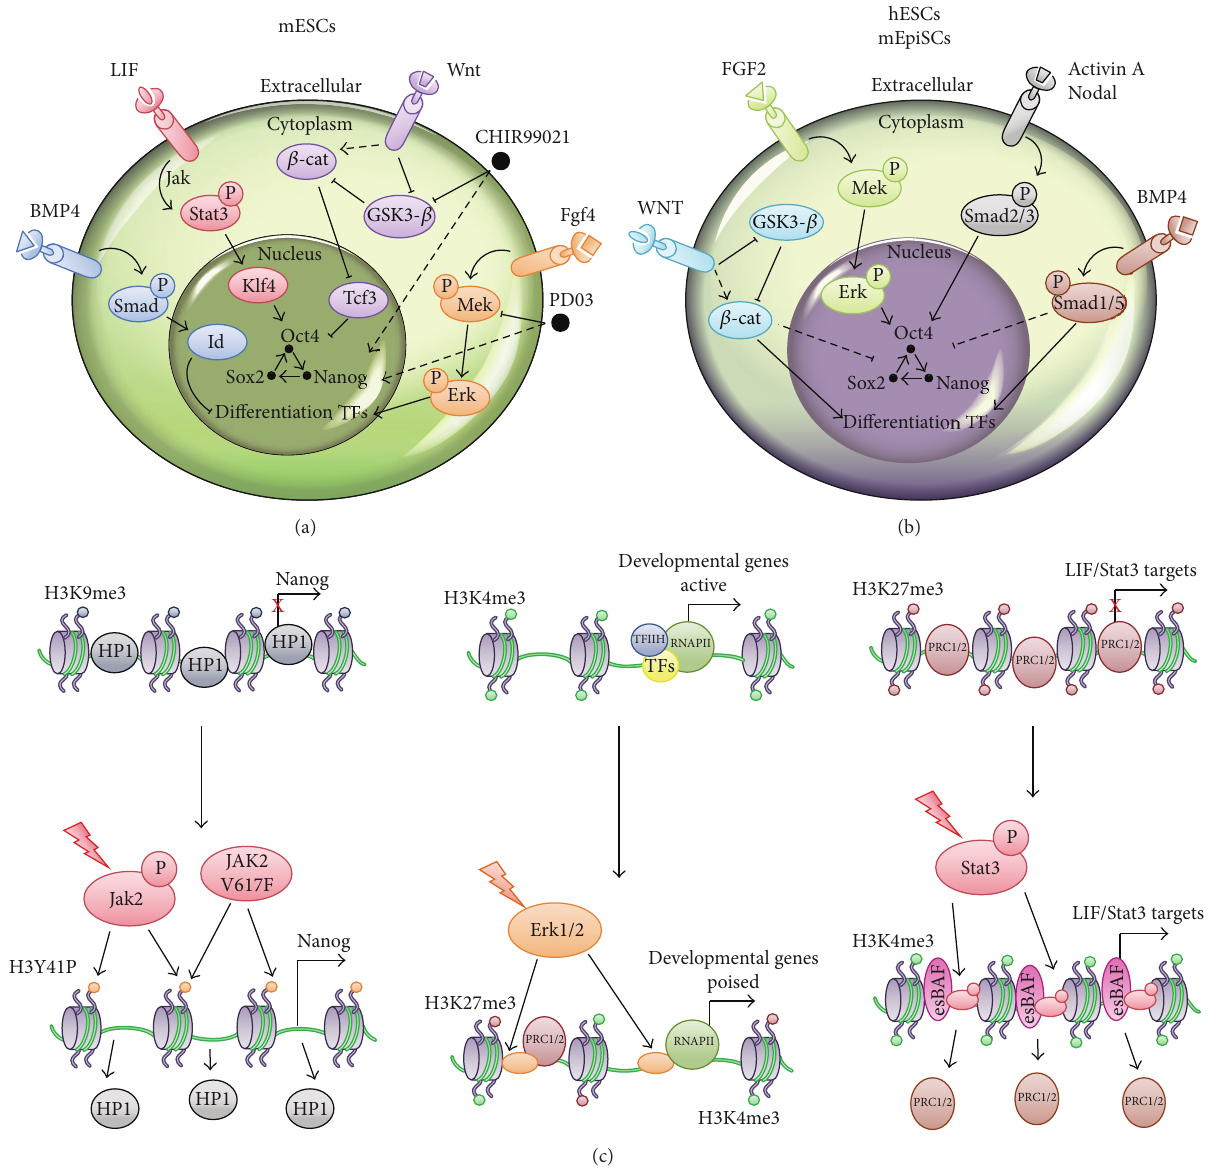
Figure 1: Signaling affecting stem cells identity and their interplay with chromatin. Key signaling pathways and relative factors contributing to the maintenance of mESCs (a) or hESCs/EpiSCs (b) identity or to their differentiation (see details in the main text). Black circles in (a) indicate the two chemicals used in the 2i culturing medium (CHIR99021 and PD03). Solid black arrows and lines indicate positive or negative modulation, respectively. Dashed black lines indicate indirect effects. Colored circles with “P” indicate phosphorylation. (c) Key examples of signaling to chromatin in ESCs. The upper panels are relative to a more differentiated state in which the LIF/Stat3 and Nanog targets are repressed while developmental genes are active. Lower panels, instead, describe embryonic stem cells chromatin features. On the right, effect of Jak2, or its constitutive active form Jak2V617F, on H3Y41P and HP1 loading on chromatin. In the middle, interconnection between Erk1/2 and the loading of PRC2 and RNA polymerase II activity at developmental genes. On the left, interplay between the esBAF complex and Stat3 in regulating LIF/Stat3 signaling pathway targets. Details of each example are reported in the main